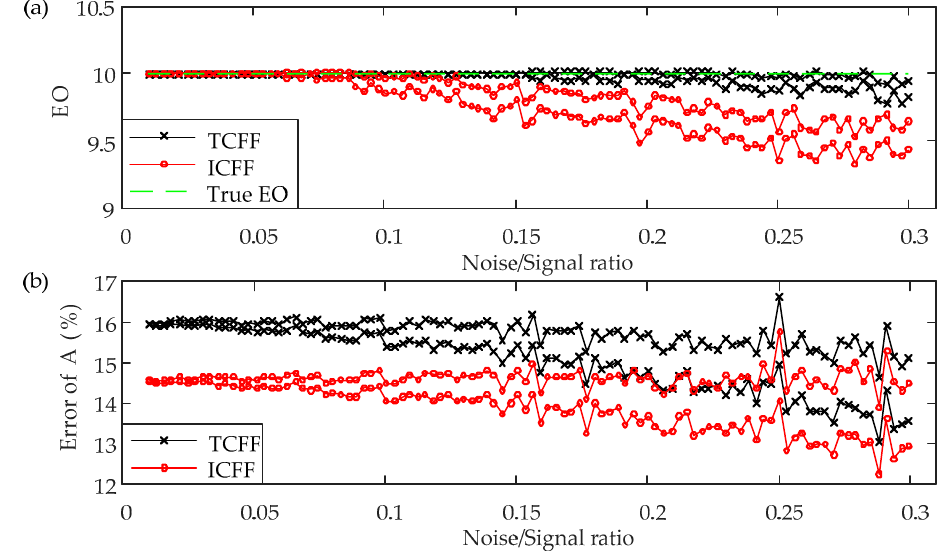
Figure 9. Results of Test 5. ( a ) 95% confidence intervals of the EO identification and ( b ) 95% confidence intervals of the relative error of the amplitude identification.